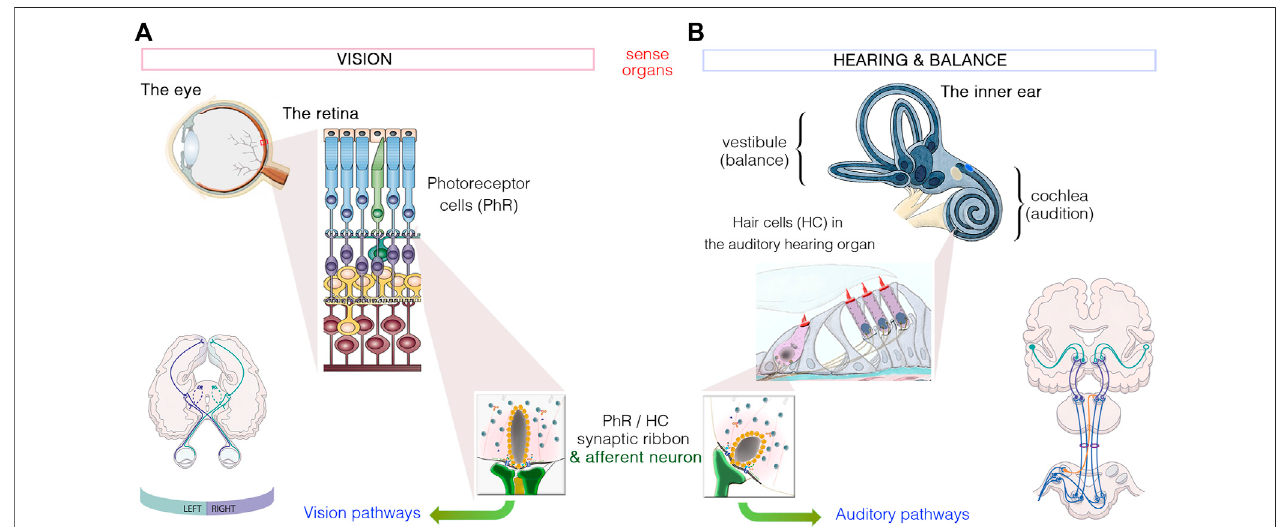
FIGURE 1 | Similarities between the sensory organs of vision and hearing. (A) : Light signals are transduced by the outer segments of the photoreceptors, in the retina. (B) :Hearingandbalancearedependentontheprocessingofsoundwavesand/ormovementwithinthehairbundles,whichcrownhaircellslocatedinthecochlea and vestibule of the inner ear, respectively. Photoreceptors and hair cells have synaptic active zones different from those of brain conventional synapses in that they are associated with an electron-dense ribbon surrounded by tethered synaptic vesicles. The neurotransmitter released from all photoreceptor cells and hair cells is glutamate, which creates the electrical signal conveyed by afferent neurons through either the visual or auditory pathways to the brain.